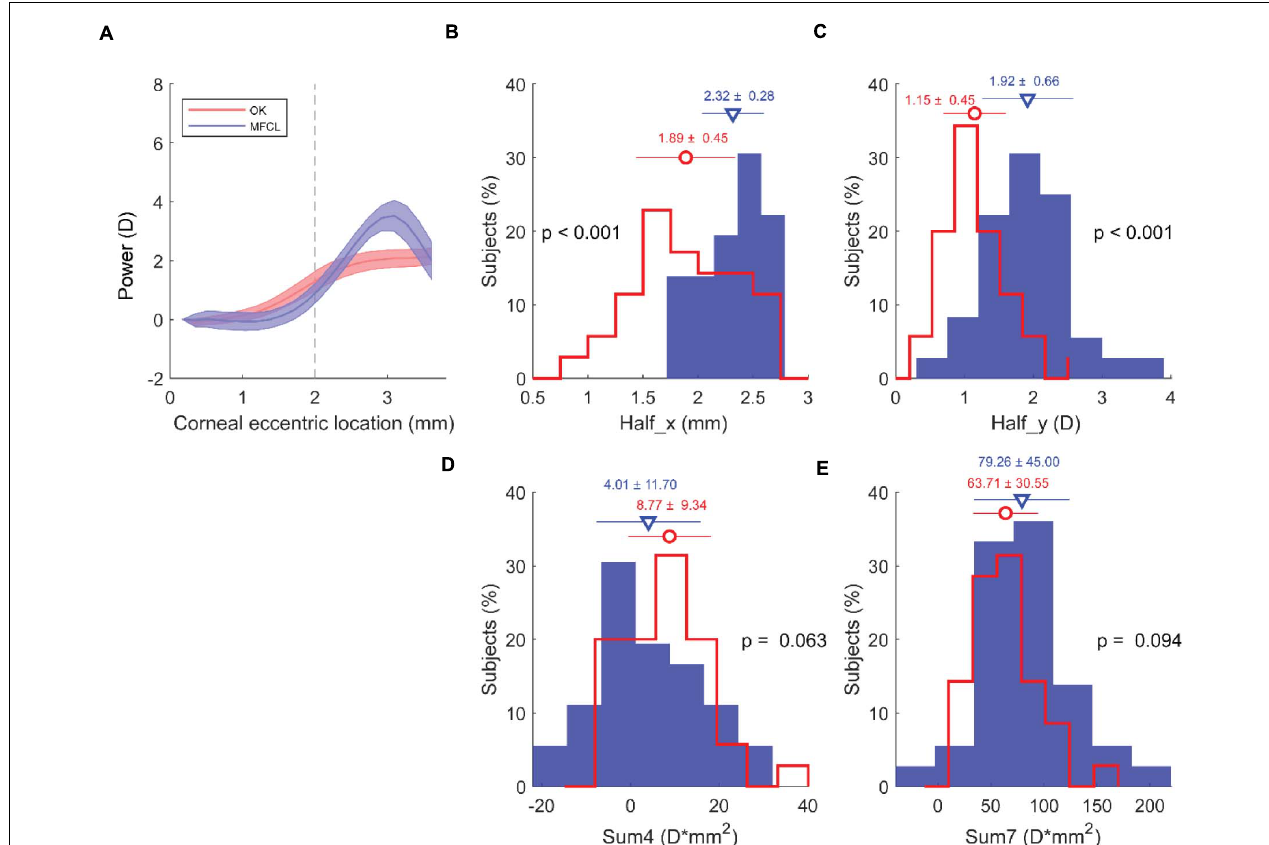
FIGURE 3 | RCRPS data from all subjects. (A) RCRPS profiles for the OK group (red) and MFCL group (blue). Solid line: mean value; shaded area: 95% confidence interval for the population means. (B) Half_x, (C) Half_y, (D) Sum4, and (E) Sum7. (B–E) OK group, red line; MFCL group, blue bars. RCRPS, relative corneal refractive power shift; D, diopter; OK, orthokeratology; MFCL, multifocal soft contact lens. Half_x, the corneal eccentric location where RCRPS reached the half peak value; Half_y, half of the RCRPS peak value; Sum4, the integrated value of the RCRPS located within an area of 4-mm diameter; Sum7, the integrated value of the RCRPS located within an area of 7-mm